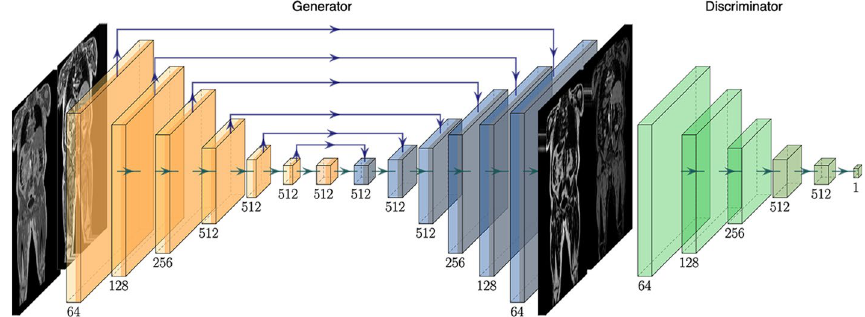
Fig. 2 Proposed 3D cGAN architecture with IP and OP signals as input and separated ˆ F and ˆ W signals as output. Filter numbers for each convolutional block are provided. The contracting path of the generator is in orange and the expansive path is in blue. The discriminator is shown in green, the different shades indicate the change in stride